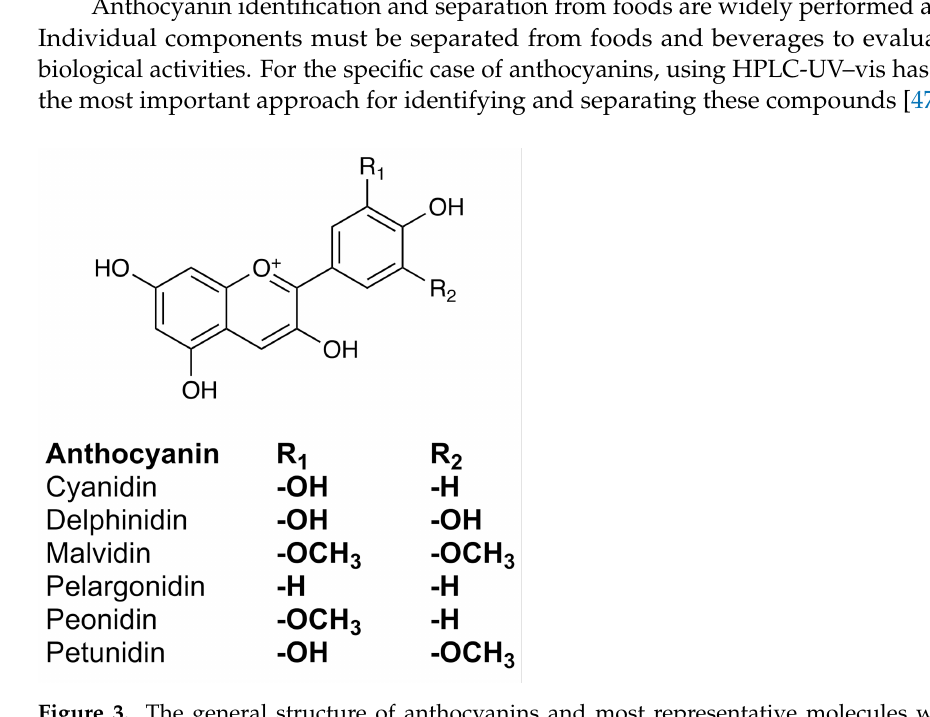
Figure 3. The general structure of anthocyanins and most representative molecules with their substituents. Adapted from